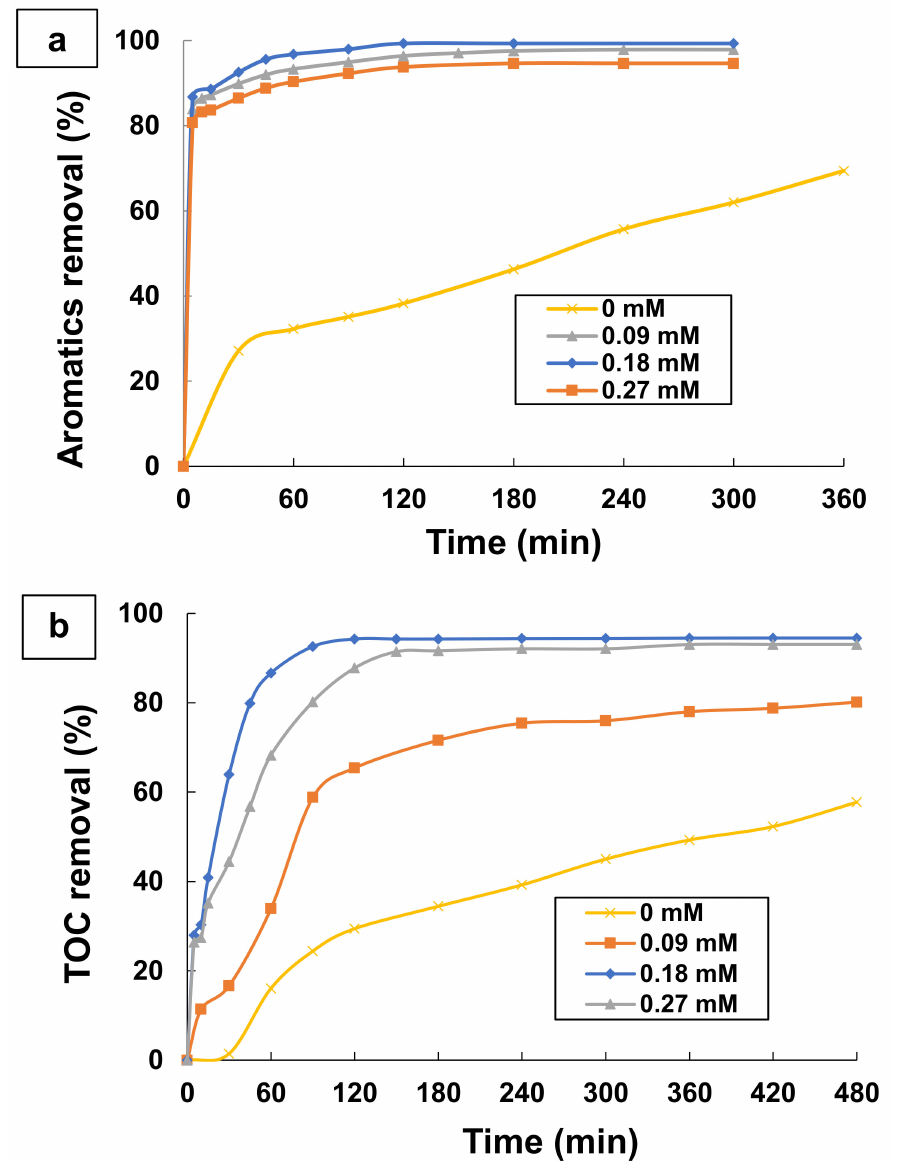
Figure 6. Effect of Fe 2+ amount on ( a ) Aromatics removal and ( b ) TOC removal by photo-Fenton process (UV/H 2 O 2 /Fe 2+ ). Experimental conditions: [TA] = 0.1 mM; [Fe 2+ ] = 0–0.27 mM; [H 2 O 2 ] = 29.4 mM; T = 25 ◦ C; and pH =